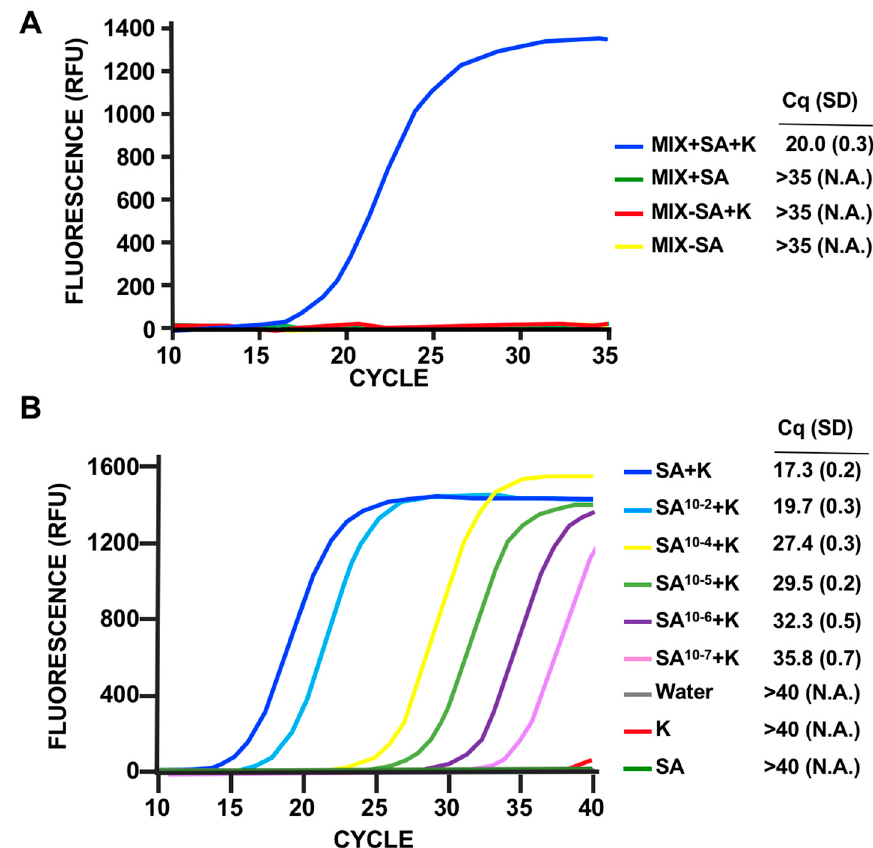
Figure 4. Specificity and sensitivity of PMMD by fluorescent qPCR using the OK2 primer pair and CsCl gradient purified phage K. ( A ) Specificity of the assay using mixed bacterial populations with and without SA. The bacterial species used as in Figure 2D (see text for details). Representation of the results as in Figure 3C. ( B ) Sensitivity of the assay of SA samples diluted as indicated. The number of bacteria ranged from 10 9 , for the undiluted sample, to 100 cells in the higher dilution (i.e., 10 − 7 ), as determined by CFU counting. Representation of the results as in Figure 3C.